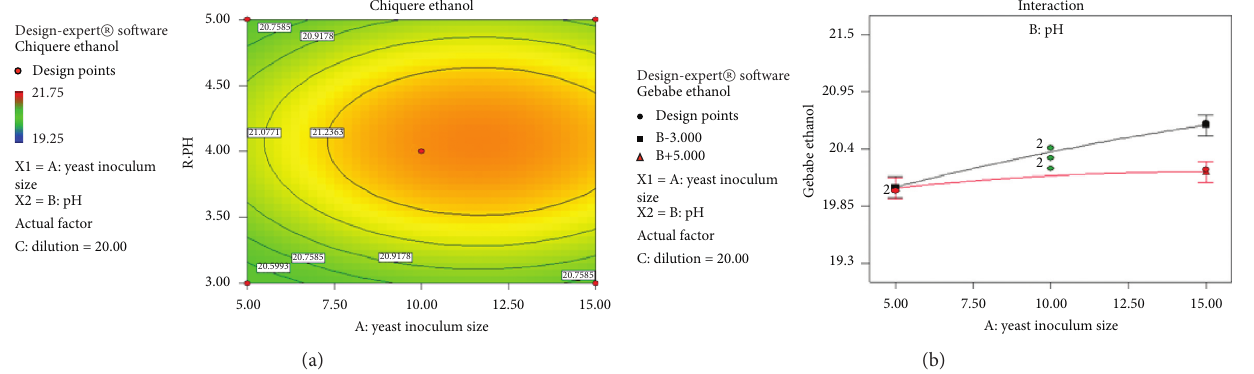
Figure 4: Contour plot for the effect of inoculum size and pH on ethanol yield. (a) Chiquere variety; (b) Gebabe variety.